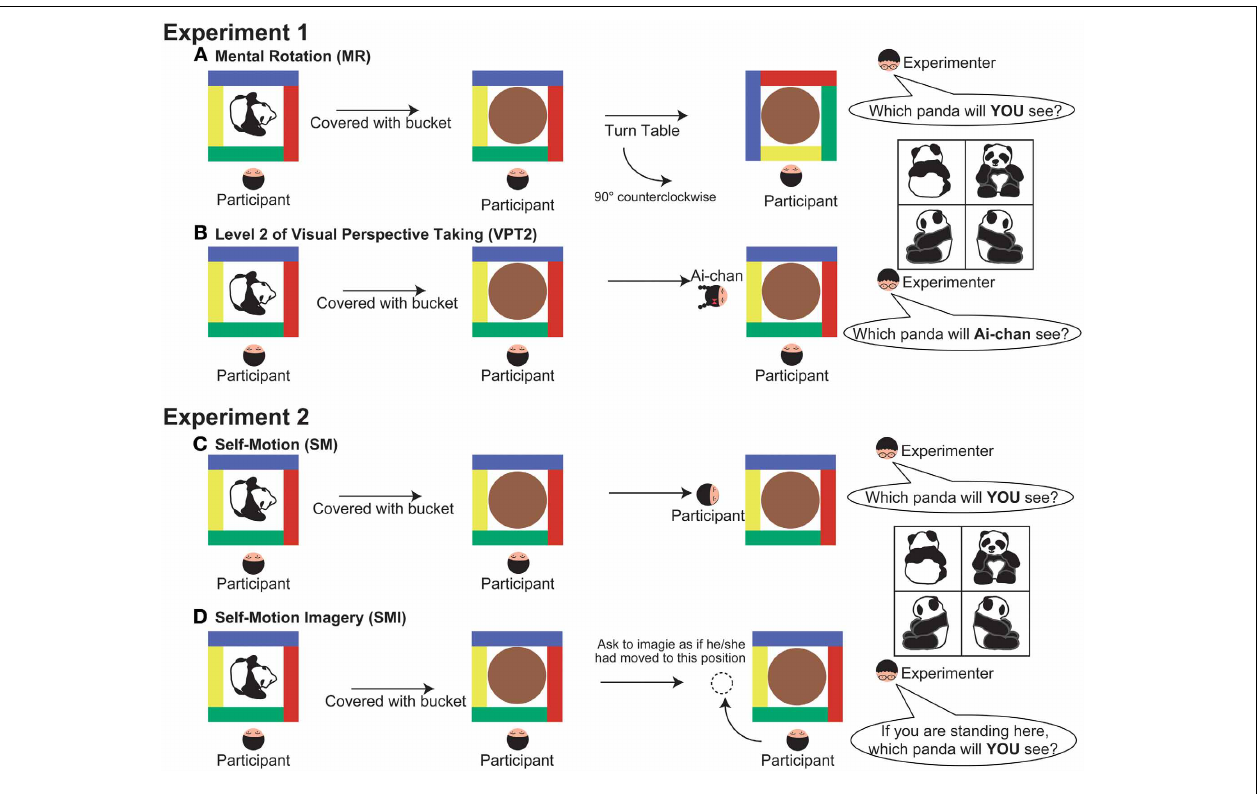
FIGURE 1 | Detail of the experimental procedure (a top-down view). (A) mental rotation (MR), (B) level 2 of visual perspective taking (VPT2), (C) self-motion (SM), and (D) self-motion-imagery (SMI). In all experimental conditions, the experimenter began by confirming that the participants were